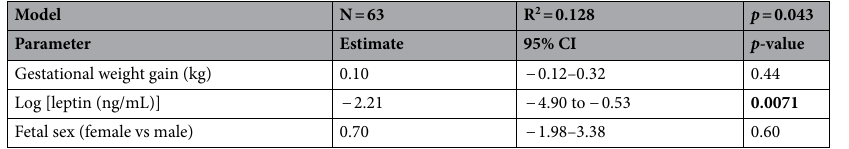
Table 3. Final generalized linear model assessing the effect of log leptin and potentially confounding variables on length of gestation after stepwise backward selection. Significant values are in bold.